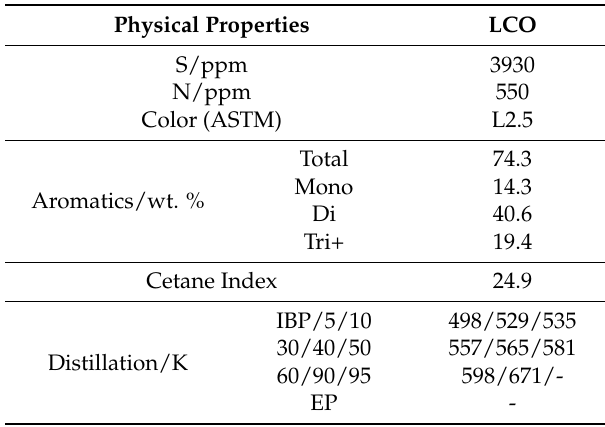
Table 2. Specifications of light cycle oil